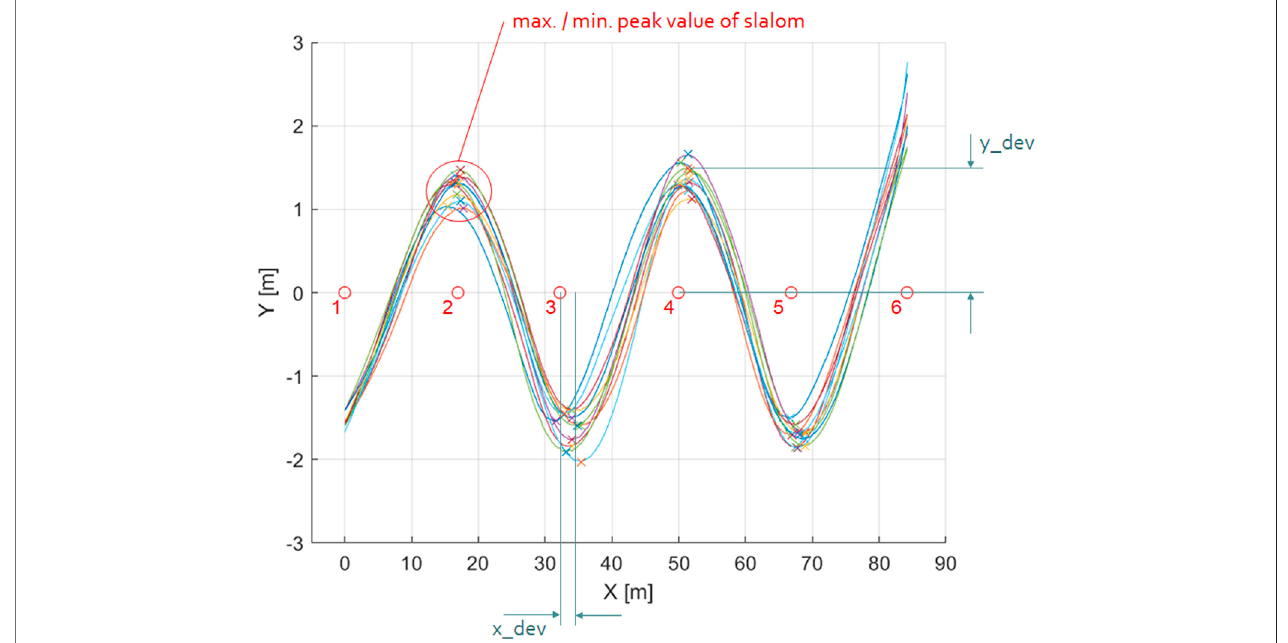
FIGURE 9 | Example of 10 runs of slalom at 10 km/h using remote station A and vehicle 2. Global navigation satellite system (GNSS) has been converted into Universal Transverse Mercator (UTM) coordinate system to make a comparison in the x – y frame.